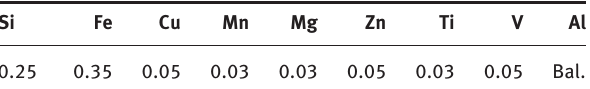
Table 1: The chemical composition (mass fraction in %) of pure aluminum